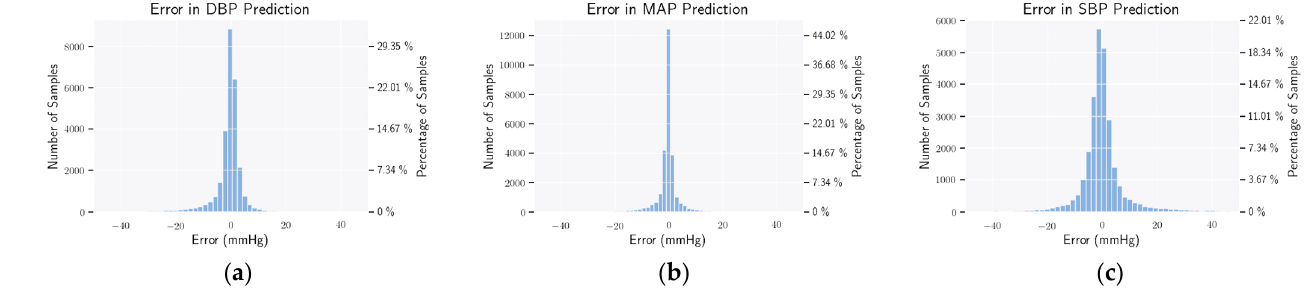
Figure 6. Mean error histogram. Here, we show how the MAE of DBP ( a ), SBP ( b ), and MAP ( c ) of the estimated samples are distributed. From the plots, all errors have a mean of zero and a small standard deviation, except SBP.